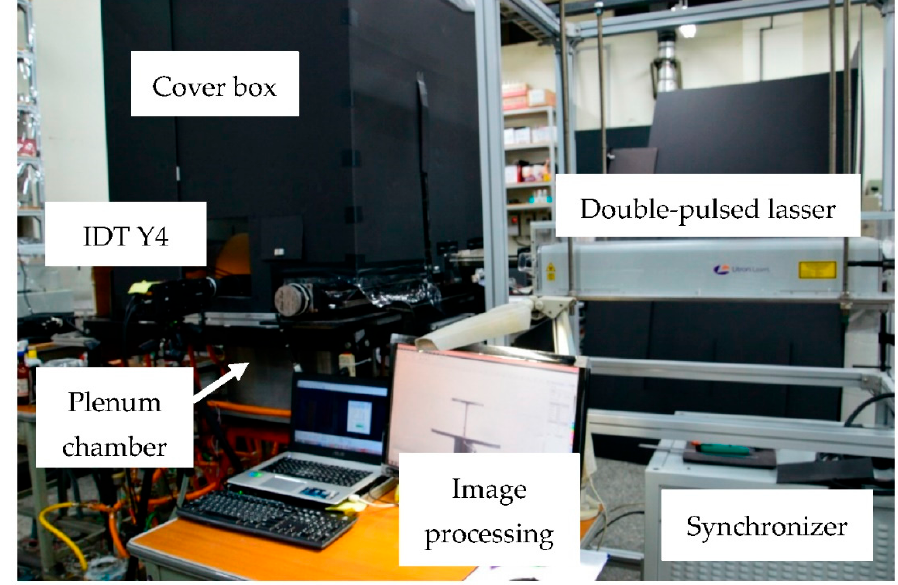
Figure 2. Two-dimensional high-speed PIV system setup.